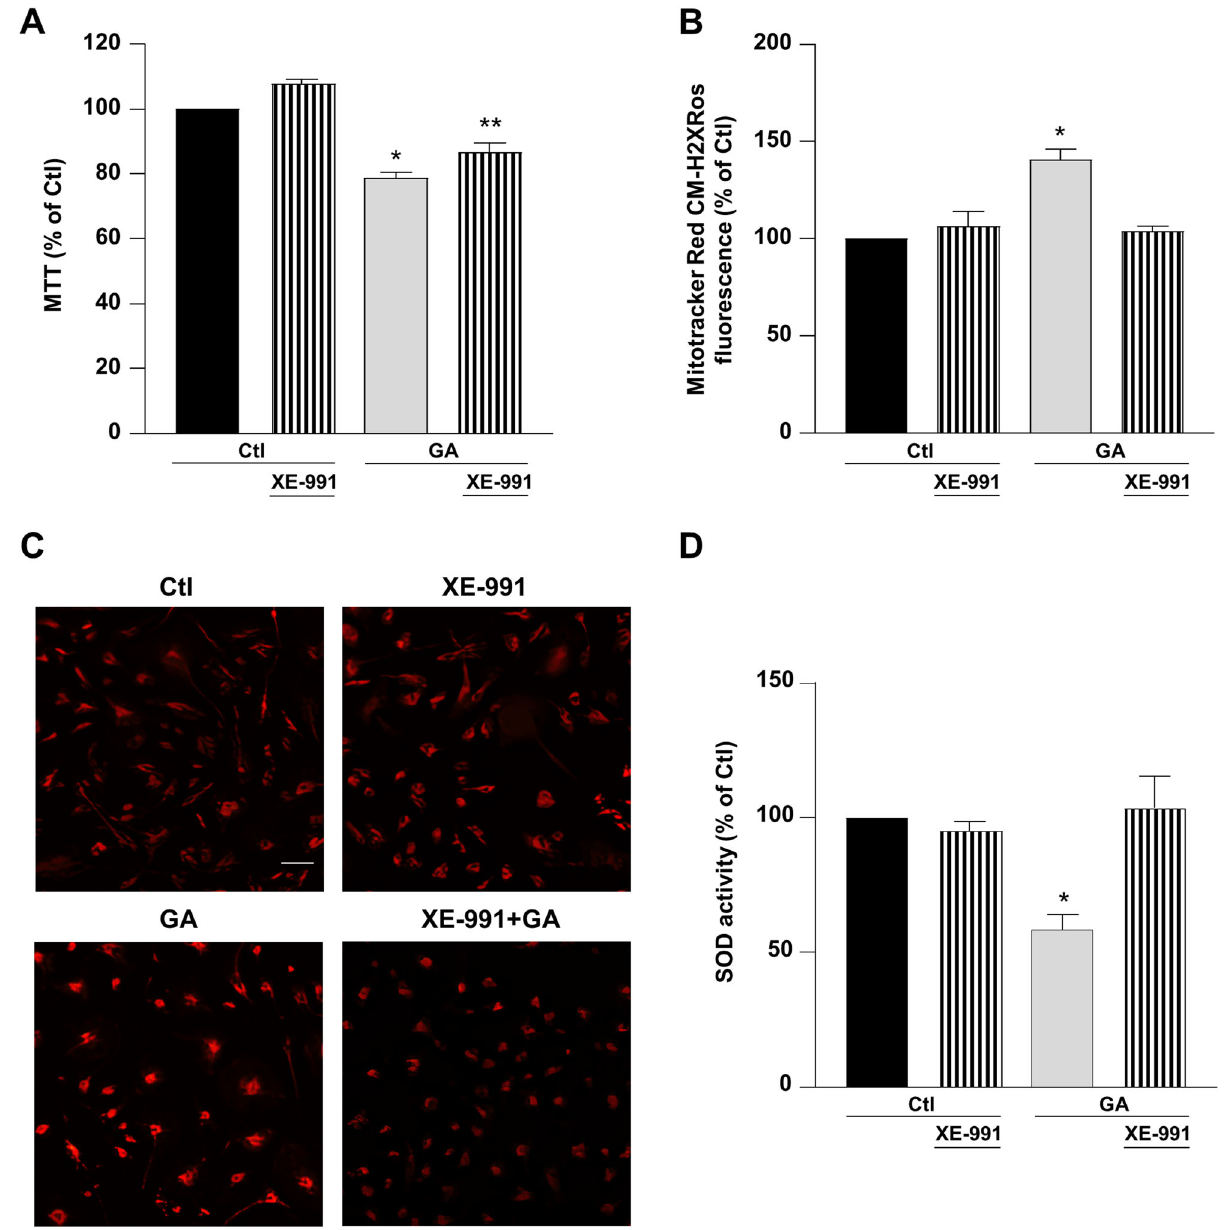
Fig. 2 The neuroprotective effect of XE-991 (300 nM) on cell viability, mitochondrial ROS production, and SOD activity measured in primary rat cortical neurons. A Evaluation of the effect of 1 h exposure to XE-991 (300 nM) on mitochondrial activity, B , C mitochondrial ROS production and D) SOD activity. XE-991 (300 nM) was added 1 h before GA (1 mM) exposure and maintained for the whole GA treatment (24 h). In each experiment MTT reduction, the fl uorescence intensity of MitoTracker Red CM-H2XRos and SOD activity were expressed as control percentages. Differences among means were evaluated by one-way ANOVA followed by Dunnett ’ s post hoc test. A F (3, 23) = 32.45. Each column depicts the mean ± S.E.M. of at least three independent experiments that were performed in triplicate. *Signi fi cant versus all groups ( p < 0.0001 versus control groups and p < 0.05 versus XE-991 + GA); **signi fi cant versus all groups ( p < 0.001 versus Ctl, p < 0.0001 versus XE-991 and p < 0.05 versus GA). B F (3, 11) = 19.02. The bar plot shows the mean ± S.E.M. of the fl uorescence increase evoked by ROS production. For each experimental group, the statistical analysis was performed by using the basal values derived from at least three independent experiments, and 100 – 150 cells were recorded for each session. *Signi fi cant versus all groups ( p < 0.0001). C Representative pictures of mitochondrial ROS obtained by MitoTracker Red CM-H2XRos staining deriving from at least three independent experiments. Scale bar = 50 µm. D F (3, 18) = 8.763. Each column shows the mean ± S.E.M. of at least four independent experiments that were performed in triplicate. *Signi fi cant versus all groups ( p < 0.01 versus Ctl, p < 0.05 versus XE-991, and p < 0.001 versus XE-991 + GA). which is known to be deregulated in AD [42, 43]. We observed identi fi ed AMPK as a possible complex that could be in fl uenced by that GA signi fi cantly increased phosphorylated (Ser2448) mTOR GA treatment. Consistently, GA signi fi cantly reduced the levels of expression (p-mTOR) (Fig. 7B, D and Fig. S7). Interestingly, XE-991 phosphorylated (Thr172) AMPK α (p-AMPK α ) in both rat cortical treatment reversed the reduction in p-AMPK α and the increase in neurons and RA-differentiated SH-SY5Y cells (Figs. 7A, C and Fig. p-mTOR expressions observed after GA treatment (Fig. 7). S6). As a downstream target of AMPK, we then checked for mTOR, Cell Death Discovery (2022)